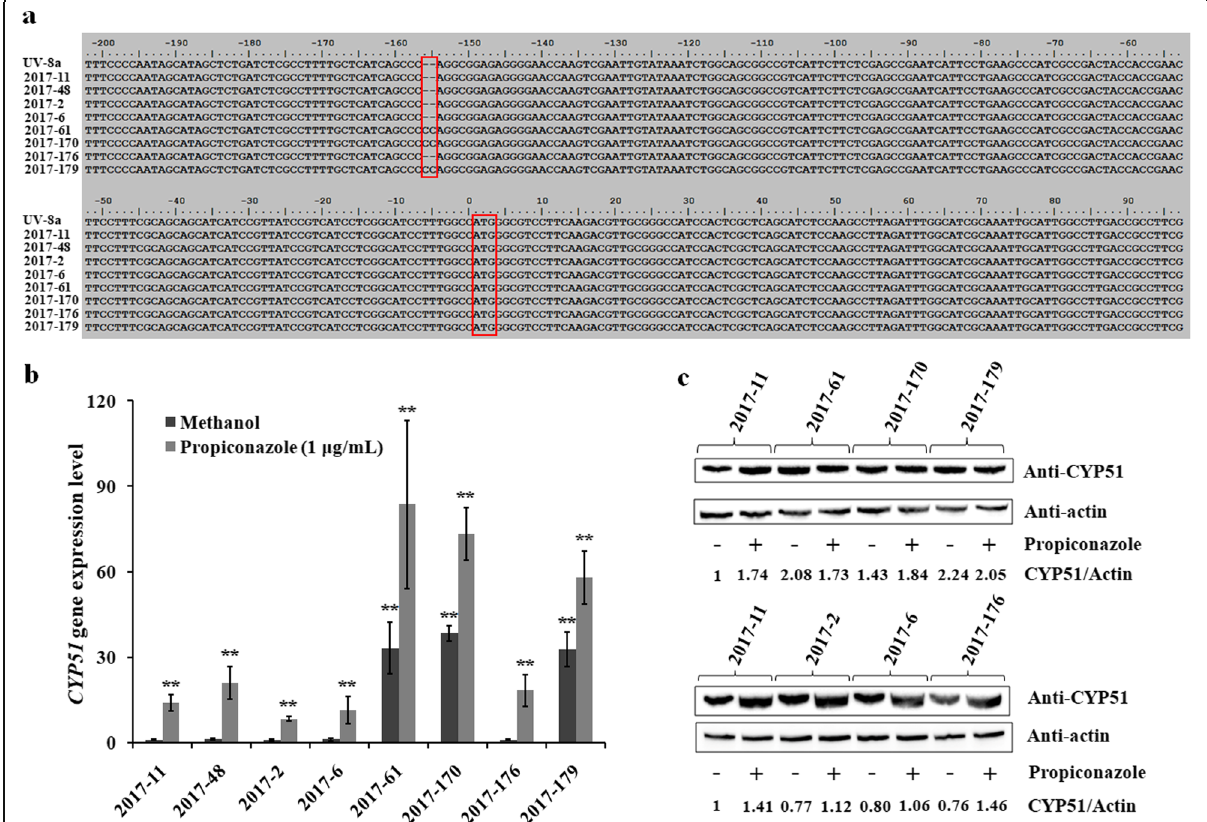
Fig. 2 Sequence and expression of the CYP51 gene and its encoded protein in propiconazole-resistant U. virens isolates. a Sequencing data upstream of the CYP51 coding region in propiconazole-sensitive and -resistant isolates in comparison to the whole genome sequence of the U. virens s train UV-8a. b The expression level of CYP51 in the propiconazole-sensitive and -resistant isolates. The expression of CYP51 in the propiconazole-sensitive isolate 2017 – 11 was set as 1. Values are means ± SE of three biological replicates. ** P < 0.01 ( t -test). c The level of CYP51 protein was assayed by western blot. The protein samples were respectively extracted from the propiconazole-sensitive and -resistant isolates. The concentration of propiconazole was 1 μ